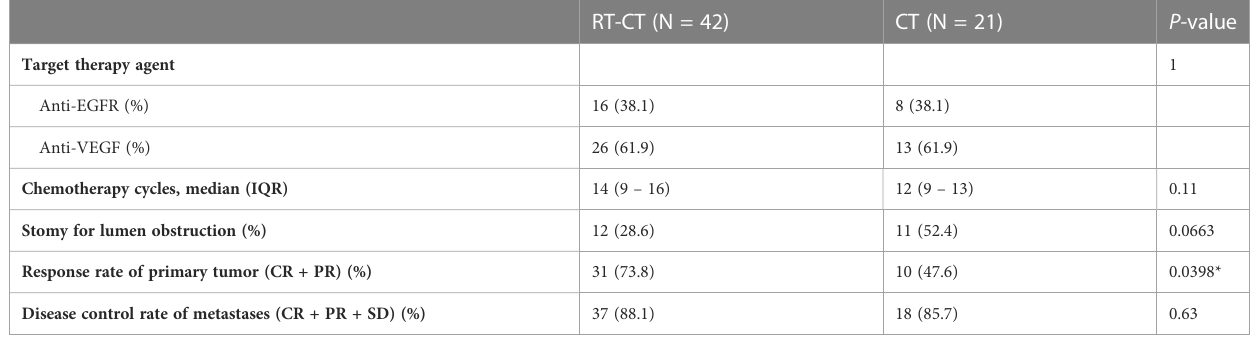
TABLE 2 Comparison of between the RT-CT 1 and CT 2 groups in terms of treatment and response.